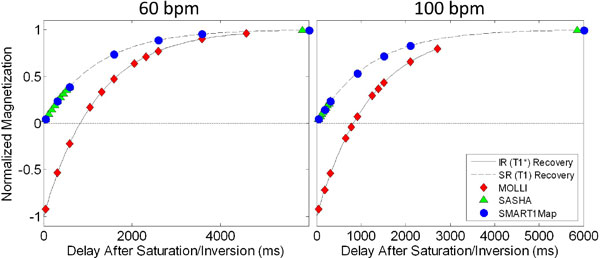
Data sampling for SMAR1Map, MOLLI, and SASHA are illustrated for heart rates of 60 bmp (left) and 100 bpm (right). Sample points are shown on the saturation recovery curve ("SR" for SMART1Map and SASHA) or inversion recovery curve ("IR" for MOLLI) for a T1 (or T1*) of 1200 ms. SMART1Map and MOLLI obtain samples that are better distributed across the recovery curve, whereas SASHA is limited to many short sample times (<RR interval). At higher heart rates, the distribution of sample points for SASHA is further compressed. Note that both SMART1Map and SASHA acquire one "infitine" sample time with no preparation pulse, illustrated here at T1 = 6000 ms for convenience.